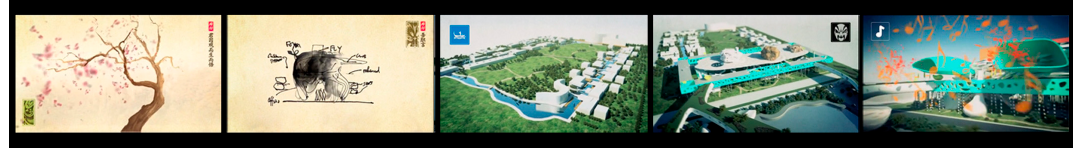
Figure 8 . AllDesign, Great Beijing Theatre and Masterplan, Langfang. Movie by AllDesign (2:44), 2010.